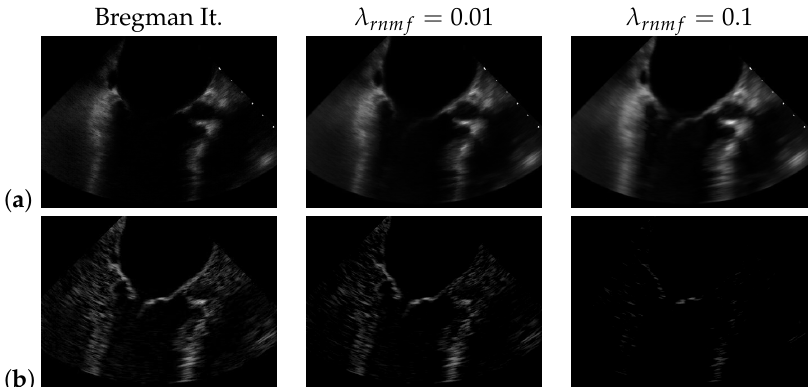
Figure 6. ( ˆ W ˆ H ) ( a ) and ˆ S ( b ) in case of using Bregman iteration and of standard robust non-negative matrix factorization (RNMF) for different values of the regularization parameter λ rnmf .